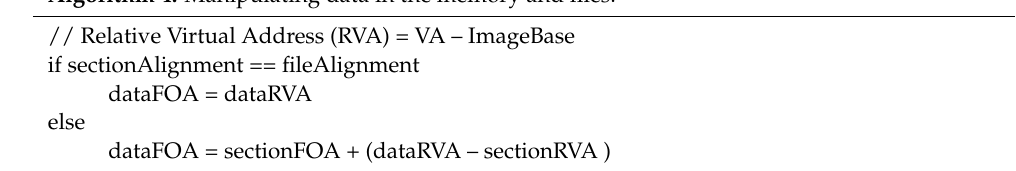
Algorithm 4: Manipulating data in the memory and